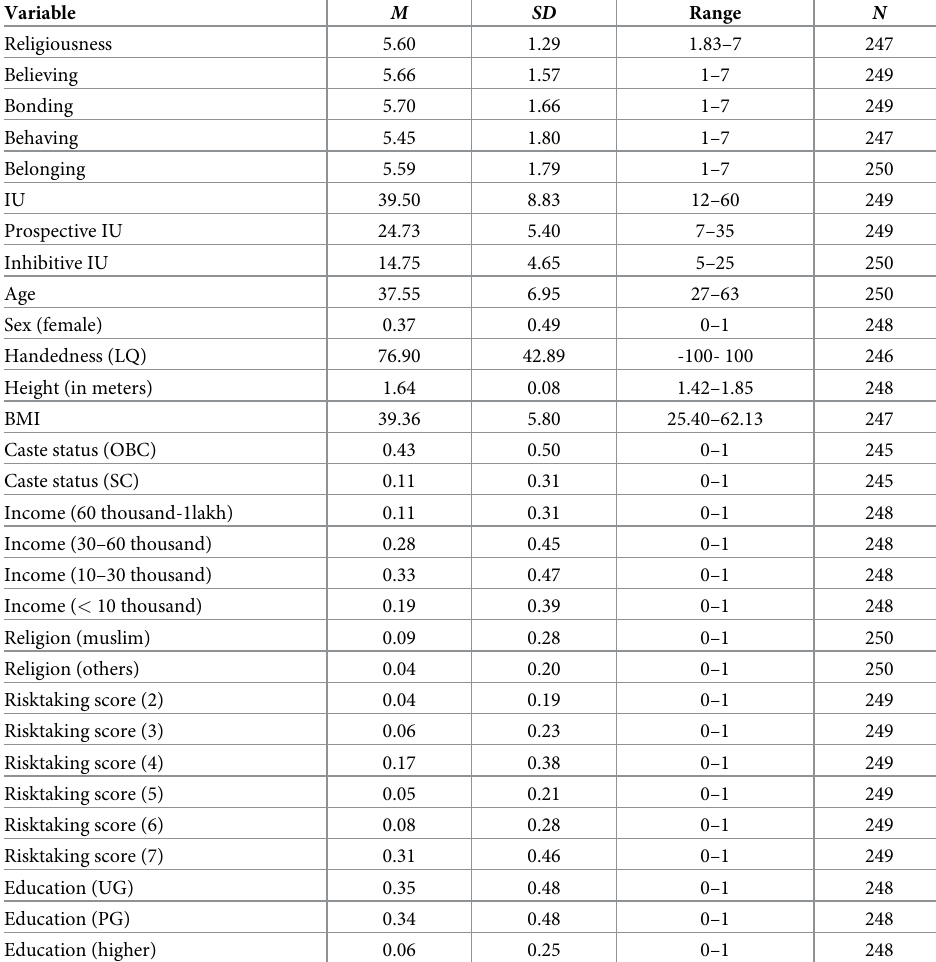
Table 10. The distribution of variables in the community sample. Variable